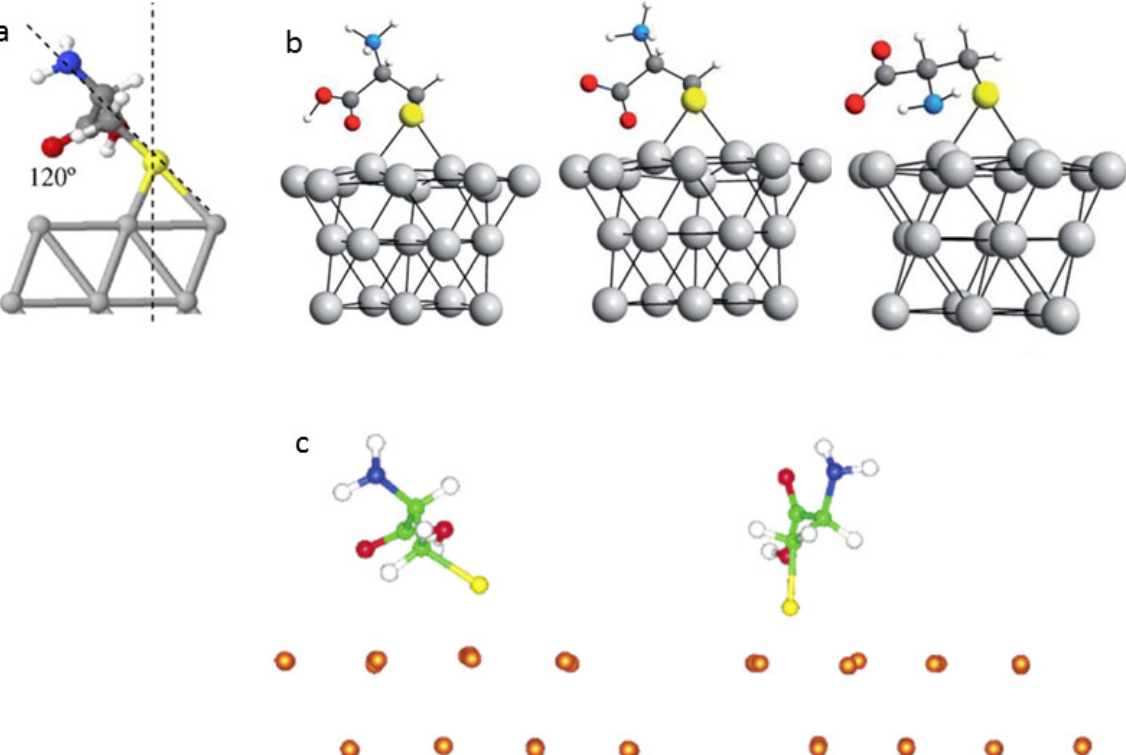
Figure 8 - L-Cys adsorbed structures onto a : Ag (111), adapted from (Santos et al. 2008), b . Pt (111) at acidic, neutral and alkaline media, adapted from (Dourado et al. 2017) and Au (111), adapted from (Di Felice et al.